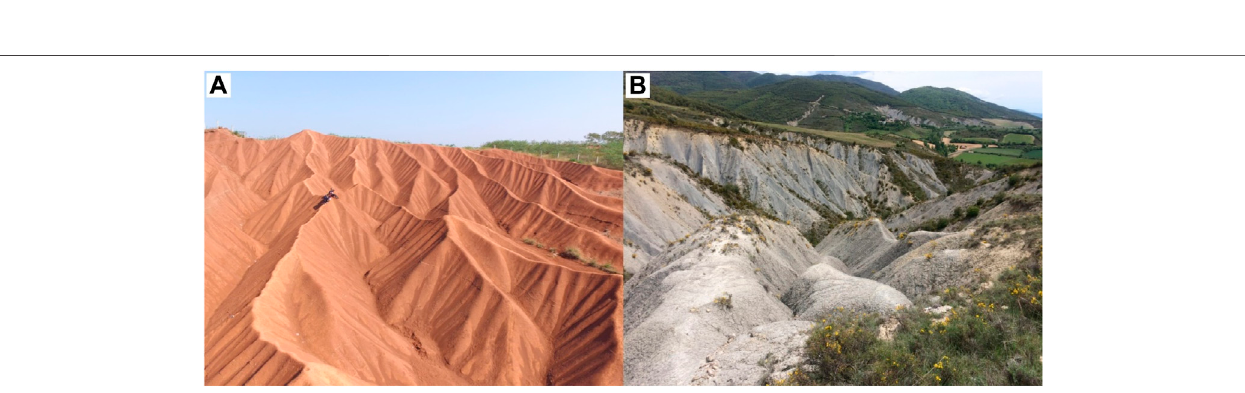
FIGURE 2 | Badland landscapes in (A) Nanxiong Basin (China) and (B) Inner Pyrenean Depression (Spain).